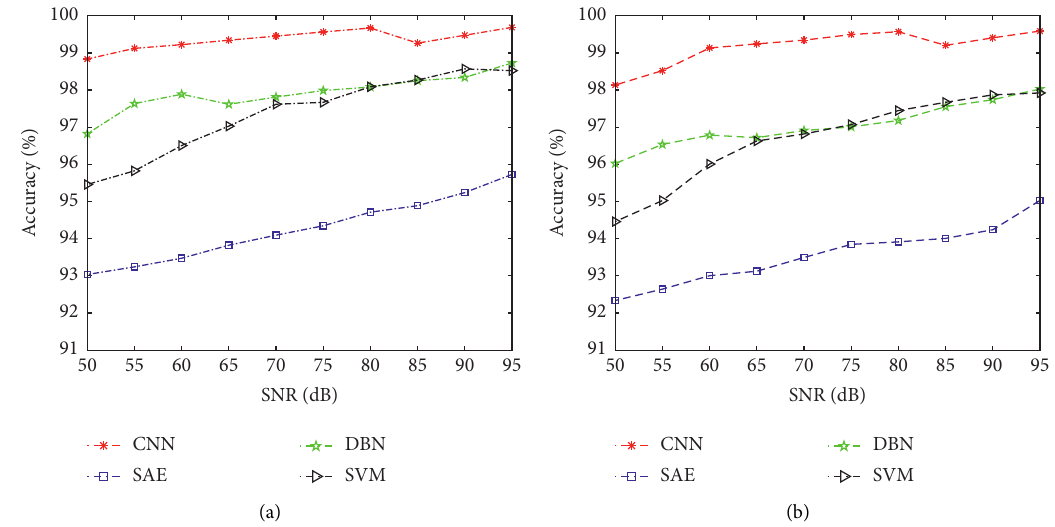
Figure 13: Classification accuracy of (a) training set and (b) testing set with noisy signal.